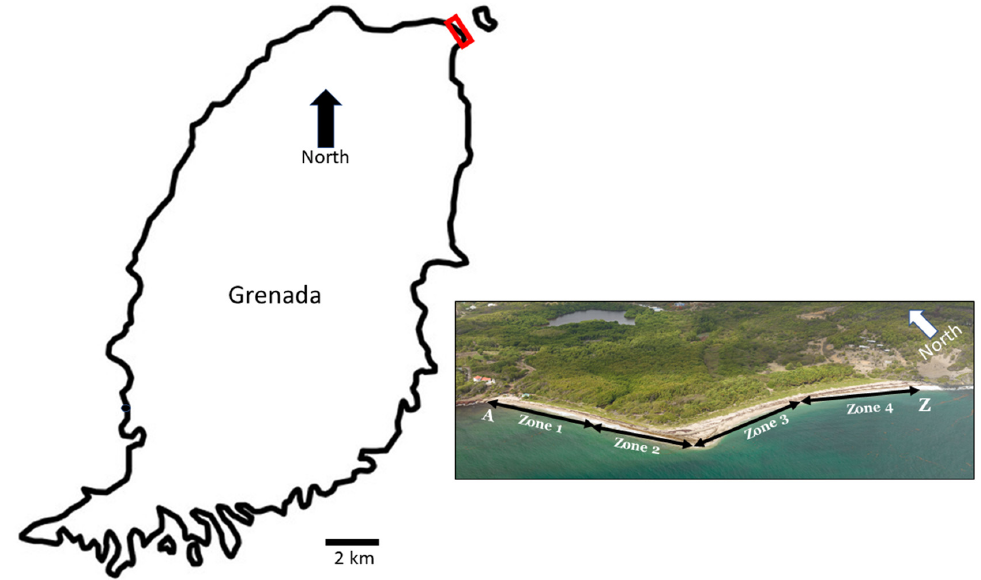
Figure 1. Geographic location of leatherback sea turtles ( Dermochelys coriacea ) nesting grounds on Levera Beach, Grenada (red square) and schematic of 187 m zones 1–4 and 30 m subzones A-Z used to mark and relocate nests at excavation. (Photo courtesy of Nicolas Winkler).